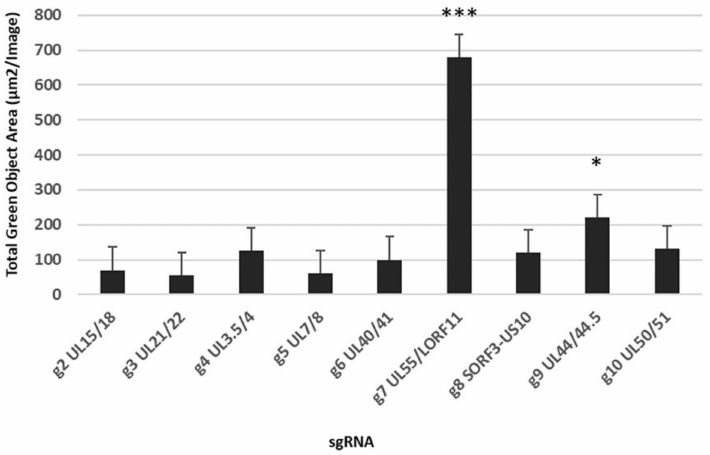
Figure 2. The total positive green cell area measurement with multiple gRNA target sites in first plaque purification of DEV-OmpH-V5. Error bar = standard error of mean. (* p < 0.05, *** p < 0.001). Moreover, the GFP-positive DEV plaques generated using the UL55-LORF11 and UL44-44.5 targeting sgRNAs continued to express GFP after repeated plaque purification compared to the other sgRNAs where the GFP expression disappeared during plaque purification. Based on these results, UL55-LORF11 and UL44-44.5 intergenic regions were selected for the CRISPR/Cas9-based gene editing for the generation recombinant DEV- OmpH-V5 in this study (Figure 3A). The two individual sgRNAs were designated as gRNA-7 and gRNA-9, respectively.